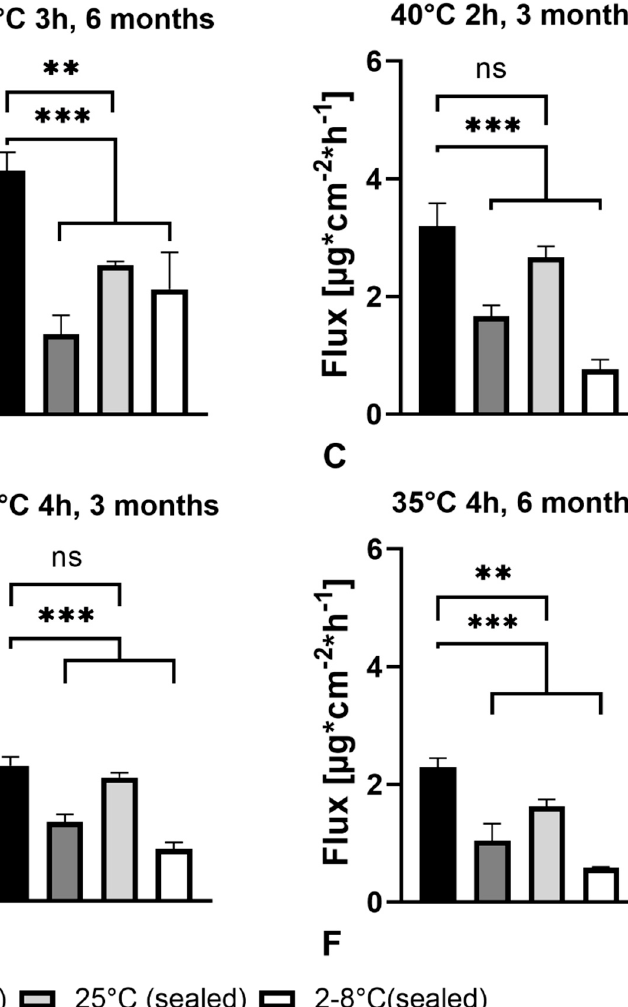
Figure 8. E2 permeation of 35 °C, 3h after three ( A ) and six months ( B ), 40 °C, 2h after three ( C ) and six months ( D ) and of 35 °C, 4h after three ( E ) and six months ( F ) of storage. Flux values after three and six months were compared to the initial value at t = 0. * Indicates significant differences ( p < 0.05), ** indicates significant differences ( p < 0.01) and *** indicates significant differences ( p < 0.001).